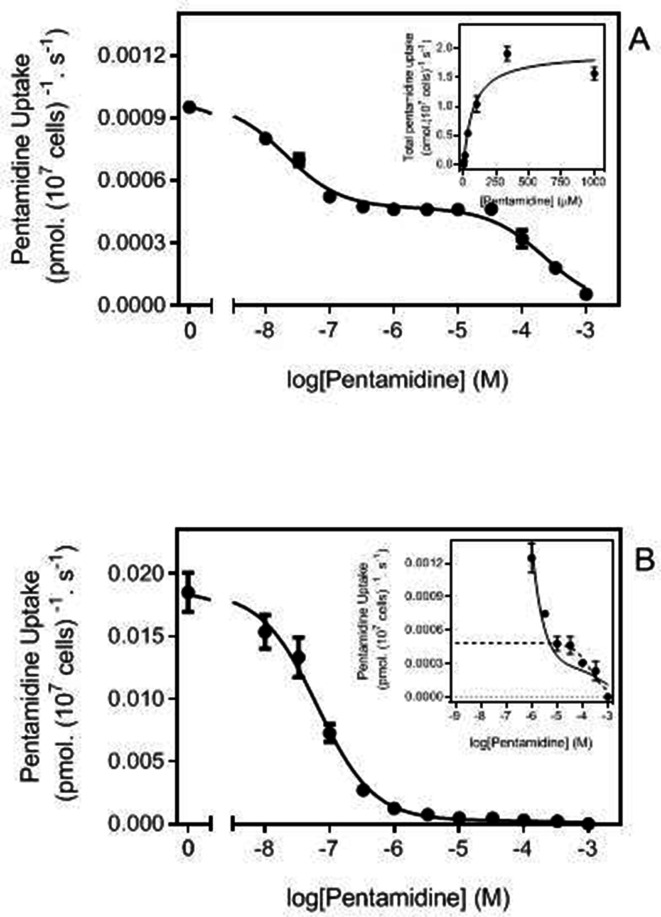
Pentamidine transport analysis for TbAQP2I190T and TbAQP2WT.(A) Transport of 30 nM [3H]-pentamidine by tbaqp2/tbaqp3 null cells expressing TbAQP2I190T, in the presence of unlabelled pentamidine at the indicated concentrations. Incubation time was 15 min, required to ensure sufficient radiolabel for accurate quantification, and uptake was linear and through zero over this period. The inhibition data were plotted to a double sigmoidal curve (Prism 7.0) with the bottom value fixed at 0. The high affinity component displayed an average an IC50 of 30.9 ± 12.2 nM (n = 3) and the lower affinity segment could be converted to a Michaelis-Menten plot for determination of Km and Vmax (inset), yielding an average Km of 59.9 ± 9.1 µM (n = 3), consistent with the Low Affinity Pentamidine Transporter (LAPT1; Bridges et al., 2007). The plot shown is one representative experiment in triplicate of three independent experiments. (B) Like (A) but with tbaqp2/tbaqp3 null cells expressing TbAQP2WT. Incubation time was 20 s (linear phase). The high affinity phase had statistically identical EC50 (41 ± 17 nM; p>0.05) as TbAQP2I190T. The inset shows a zoom-in on the low-affinity part of the curve (LAPT1 contribution), with the dotted line representing a theoretical sigmoid plot for one inhibitor, with the upper limit fixed at the value obtained for 10 μM pentamidine. The low affinity component was also statistically identical in the two strains (TbAQP2-WT Km = 82.7 ± 17.5 µM (n = 3; p>0.05)). Note that the amount of [3H]-pentamidine taken up by the low affinity component is highly similar for the mutant (A) and control (B) cell lines, at approximately 0.0005 pmol(107 cells)−1 s−1. Both frames show one representative experiment of three repeats, each performed in triplicate. Error bars are SEM, when not shown, fall within the symbol. All data for these graphs are contained in Figure 3—source data 1.